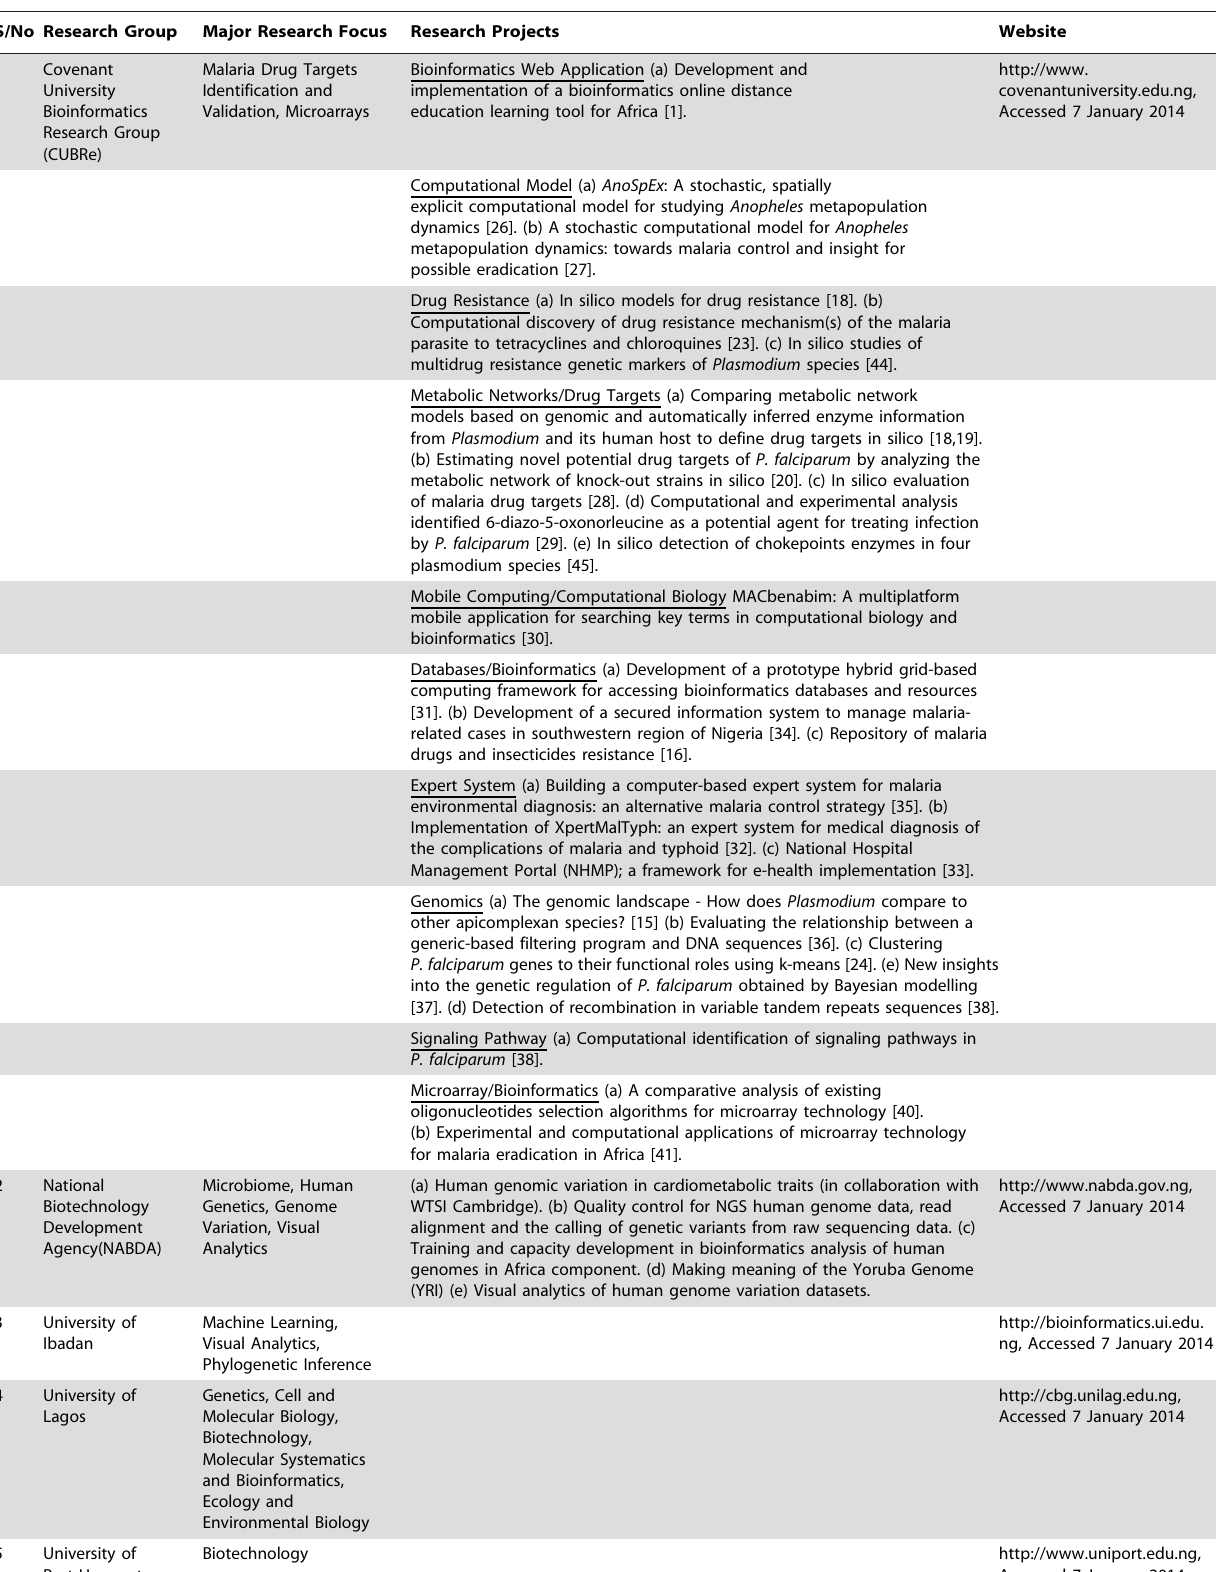
Table 1. Research foci and projects of bioinformatics research groups in